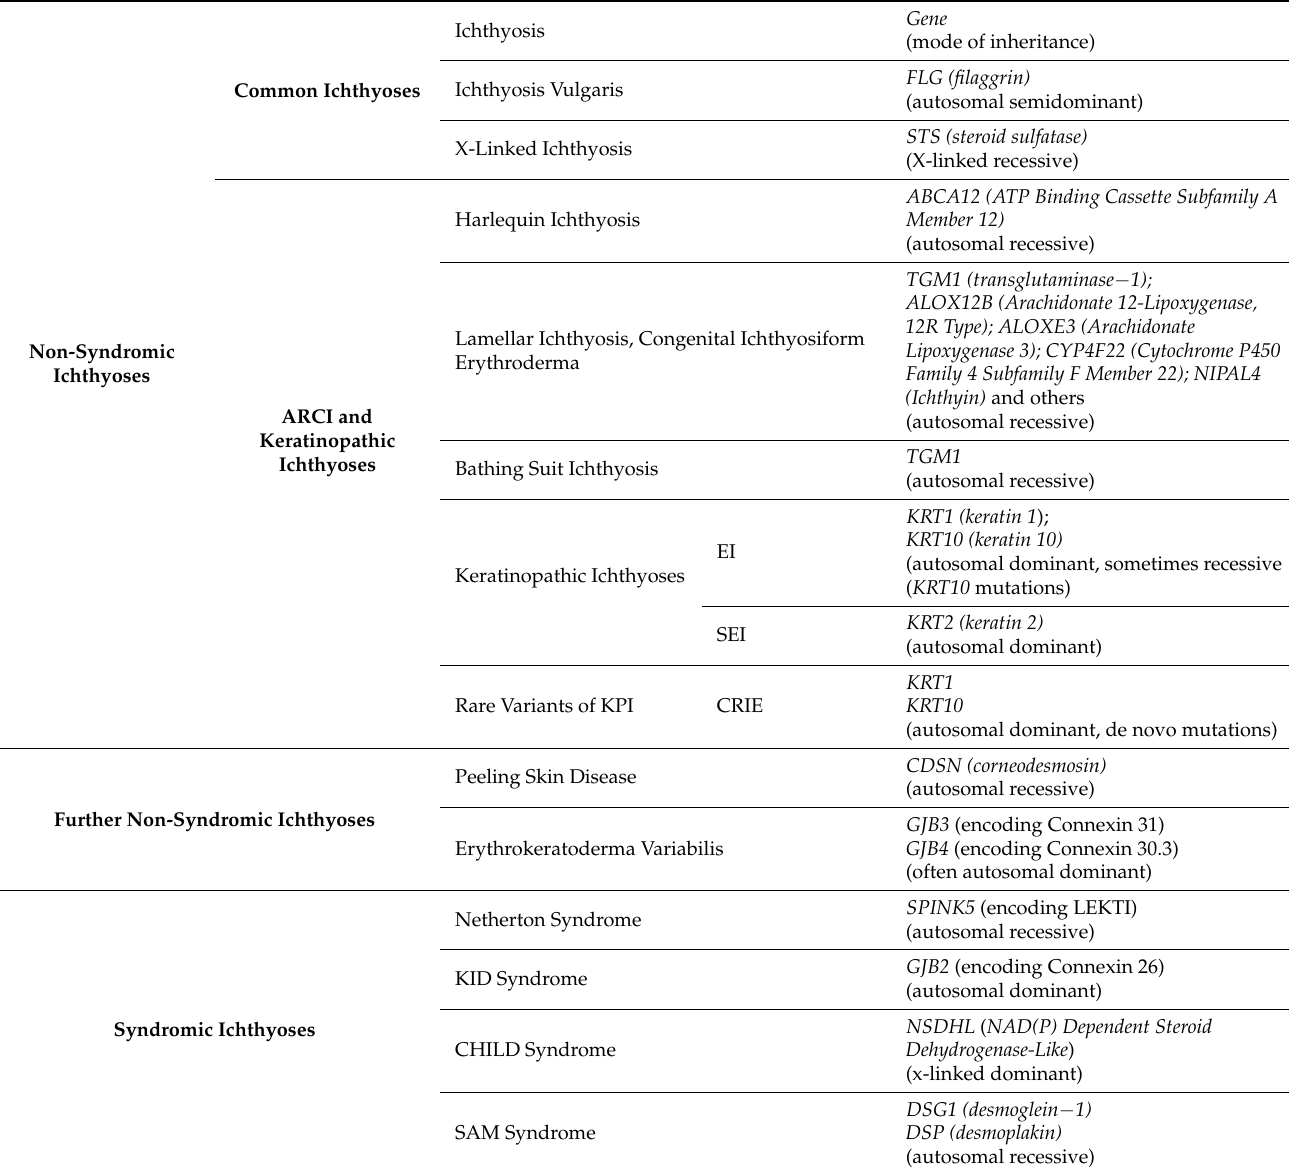
Table 3. Different types of ichthyosis with gene mutation and mode of